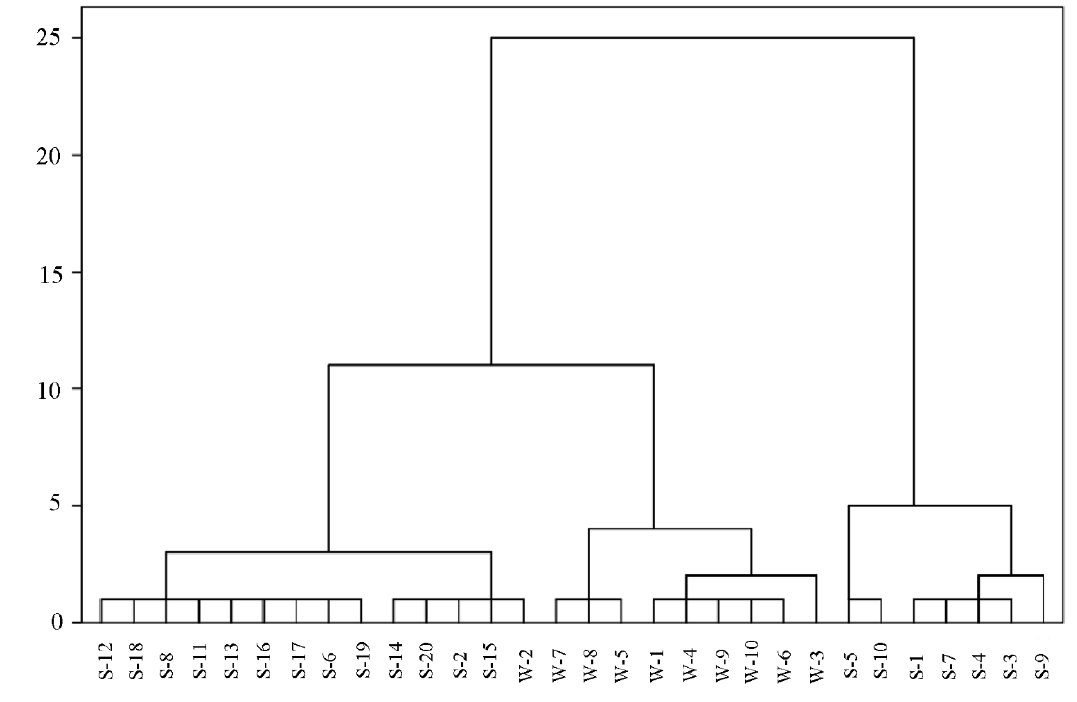
Figure 4. Dendrogram of adhesive samples.